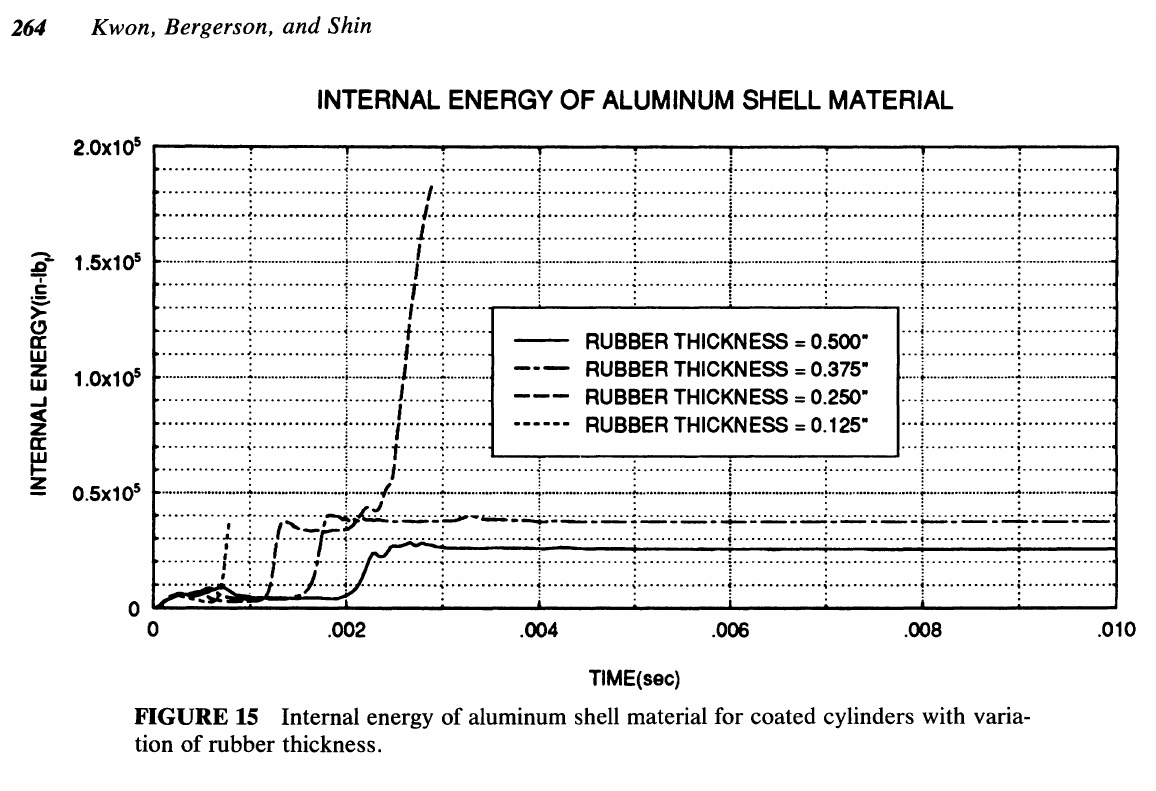
FIGURE 15 Internal energy of aluminum shell material for coated cylinders with varia tion of rubber